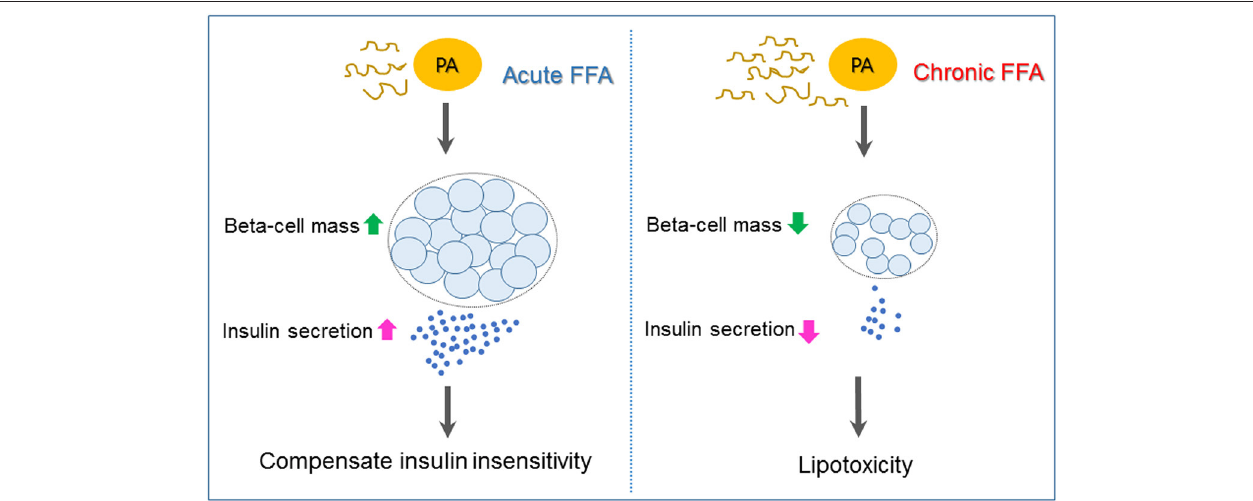
FIGURE 1 | Mechanisms underlying pancreatic beta-cell failure induced by lipotoxicity. When insulin resistance occurs, elevated free fatty acid (FFA) such as palmiate (PA) acutely increases beta-cell mass and insulin secretion to compensate for insulin insensitivity. Chronic increases of plasma FFA result in lipotoxicity, which contributes to beta-cell dysfunction and apoptosis and, as a consequence, induces type 2